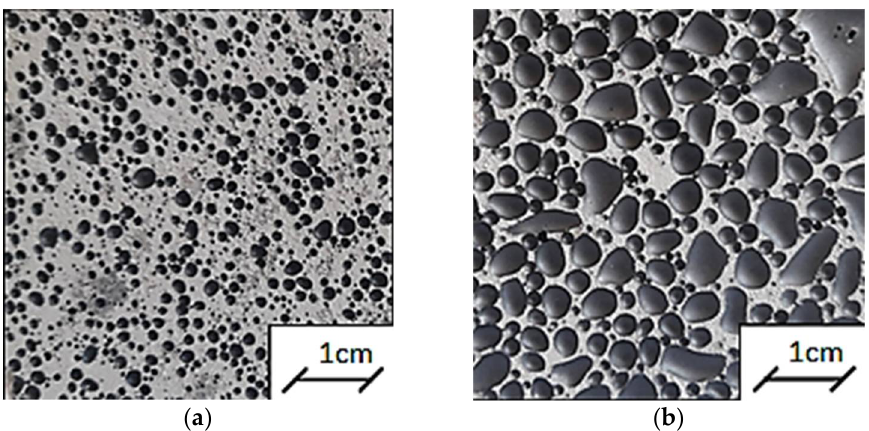
Figure 2. Reference samples used in the thermal tests after 28 days of conditioning under hygrothermal conditions: ( a ) RSS1.2, ( b ) RSF1.2.